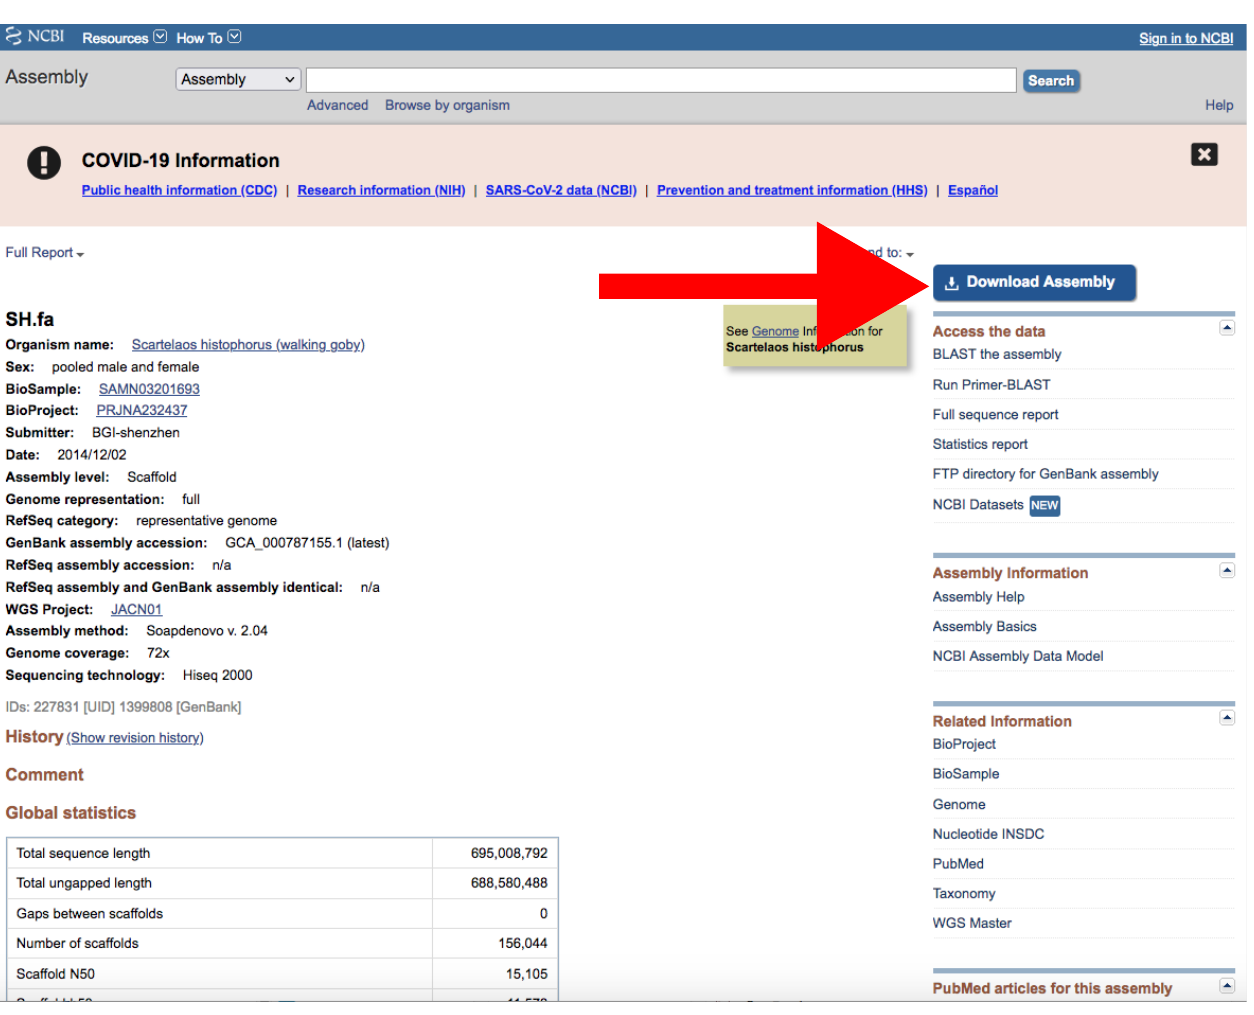
Figure 6. Example of an assembly entry. The NCBI web server will automatically redirect to a page like this if there is only one assembly that matches your query parameters. The red arrow indicates the Download Assembly button. Accessed on 27 January 2022.